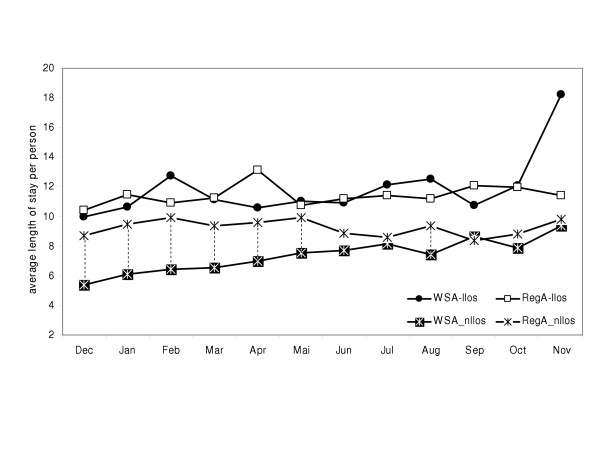
Monthly average length of stay per person of admitted nonlocal and local residents in WSA and RegA HSAo. Monthly average length of stay per person of nl-res and l-res in winter sport (WSA) and regular (RegA) HSAo; 2000–2002. nllos = nl-res length of stay, llos = l-res length of stay, ------ = significant difference.